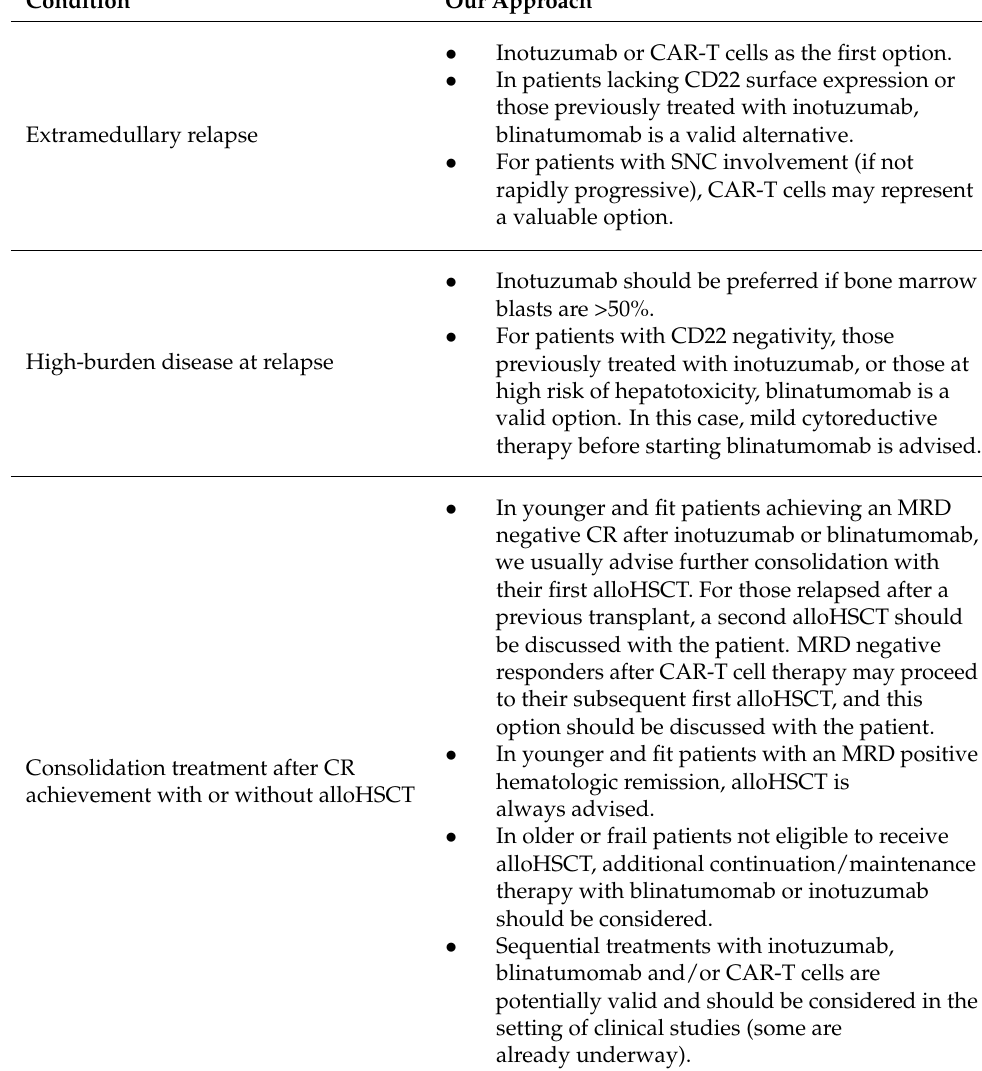
Table 2. Summary of suggested strategies according to different clinical